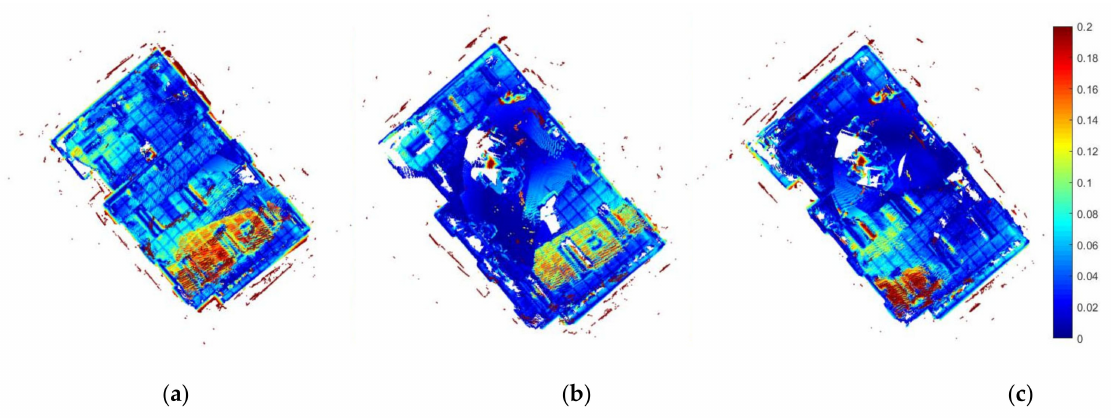
Figure 10. Texture-rich PTPD (m) between exploration models and the ground truth model.